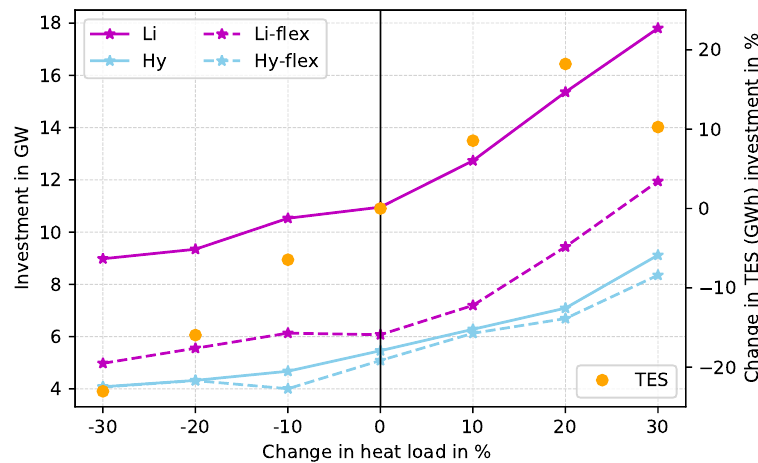
Figure 8. Sensitivity for installed storage capacities in GW in the 2050 scenario at different heat demand levels. Values for flexible heat pump operation are depicted as dashed lines. The 2050REF scenario is indicated by the vertical line inside the